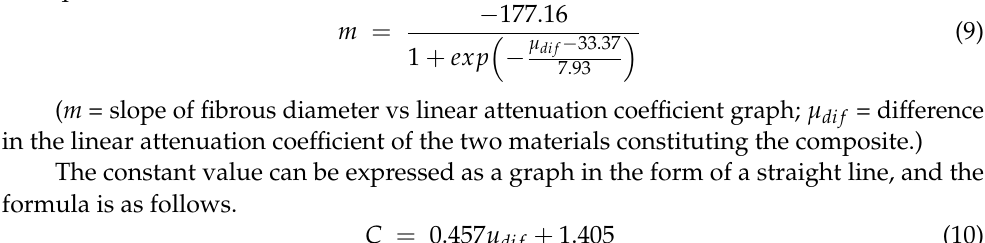
( C = y − intercept of fibrous diameter vs. linear attenuation coefficient